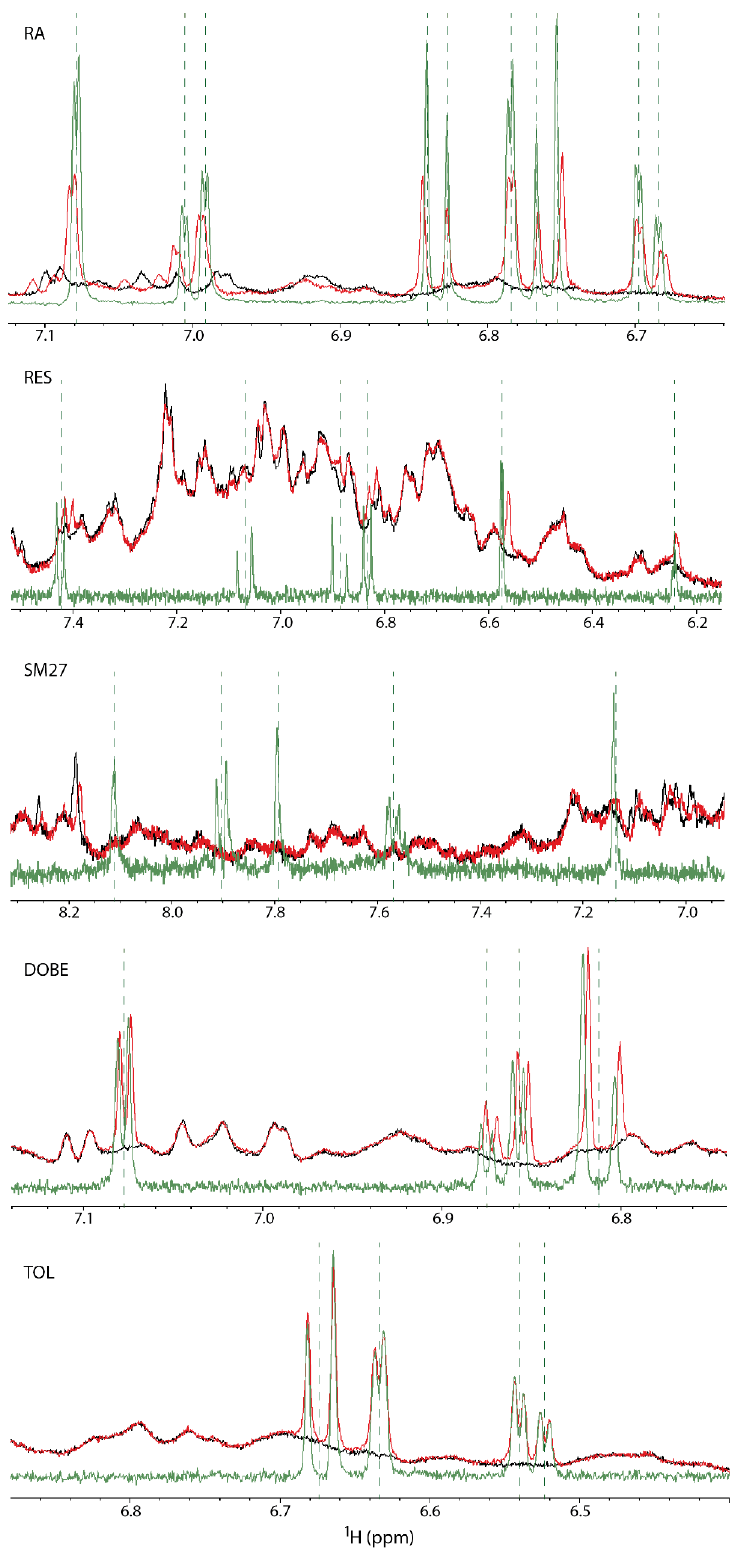
Figure 2. Comparison of 1D 1 H spectra of small molecules, as indicated in the upper left, in the presence (red, FGF2:D2:small molecule 1:1:4) or absence (green) of the FGF2/D2 complex. The spectrum of the FGF2/D2 complex ([FGF2] = [D2] = 0.2 mM) is shown in black as a reference. Vertical dashed lines are positioned at the frequencies of the free-ligand resonances.